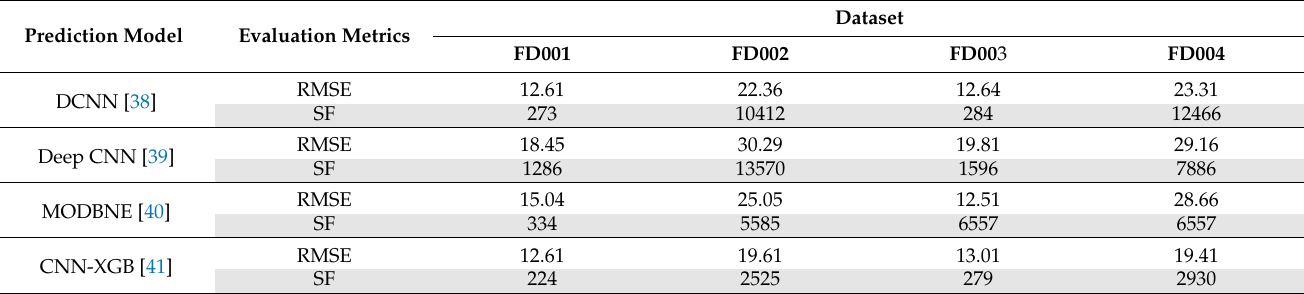
Table 6. Results of other research for centralized RUL prediction on